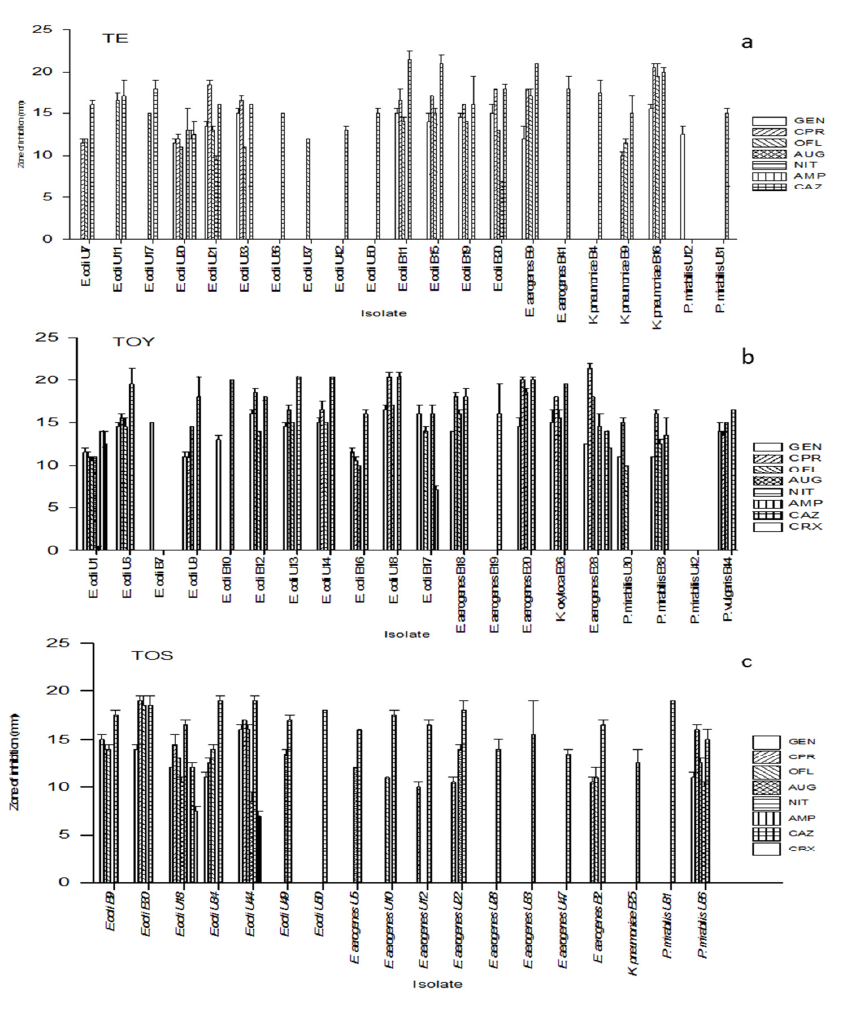
Fig. 2. Antibiotic susceptibility pattern of the isolates from the three